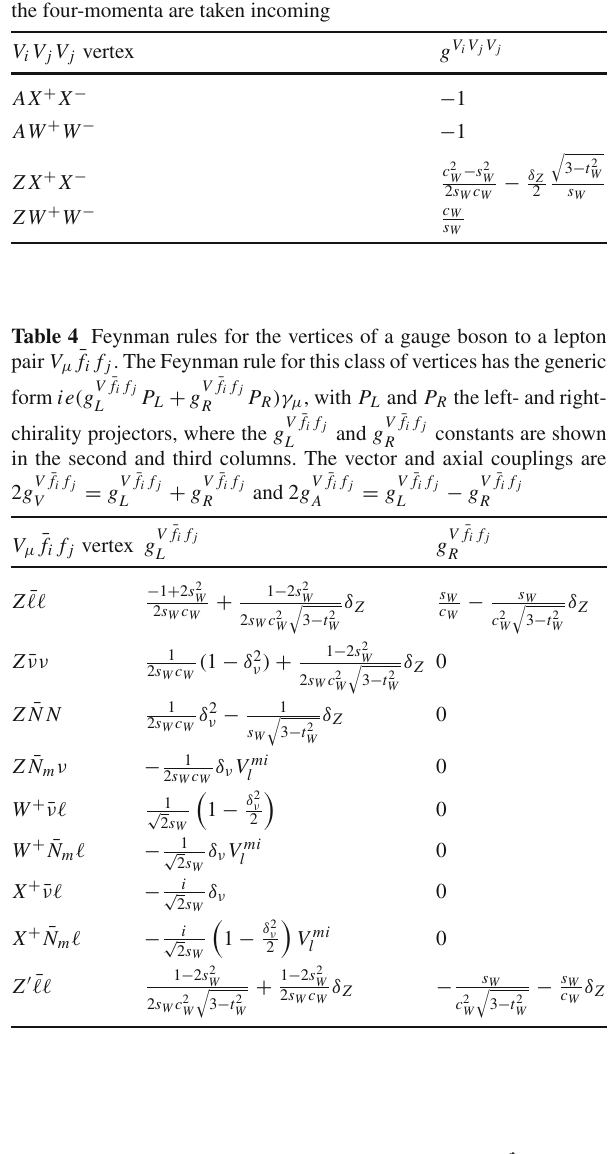
Table 3 Feynman rules for the trilinear gauge boson couplings V μ ( p 1 ) V + ν ( p 2 ) V − ρ ( p 3 ) . The Feynman rule for all these couplings have